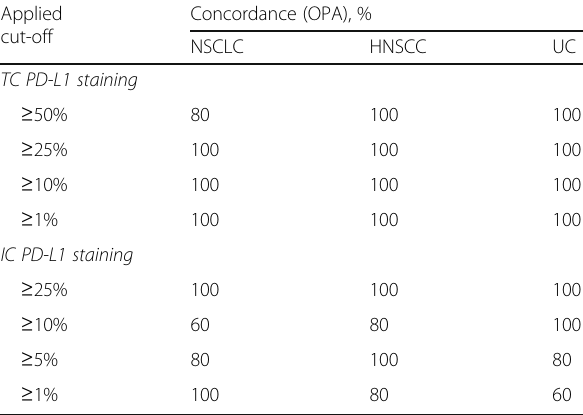
Table 5 Intra-case concordance (OPA) in PD-L1 classification at various applied cut-offs Applied